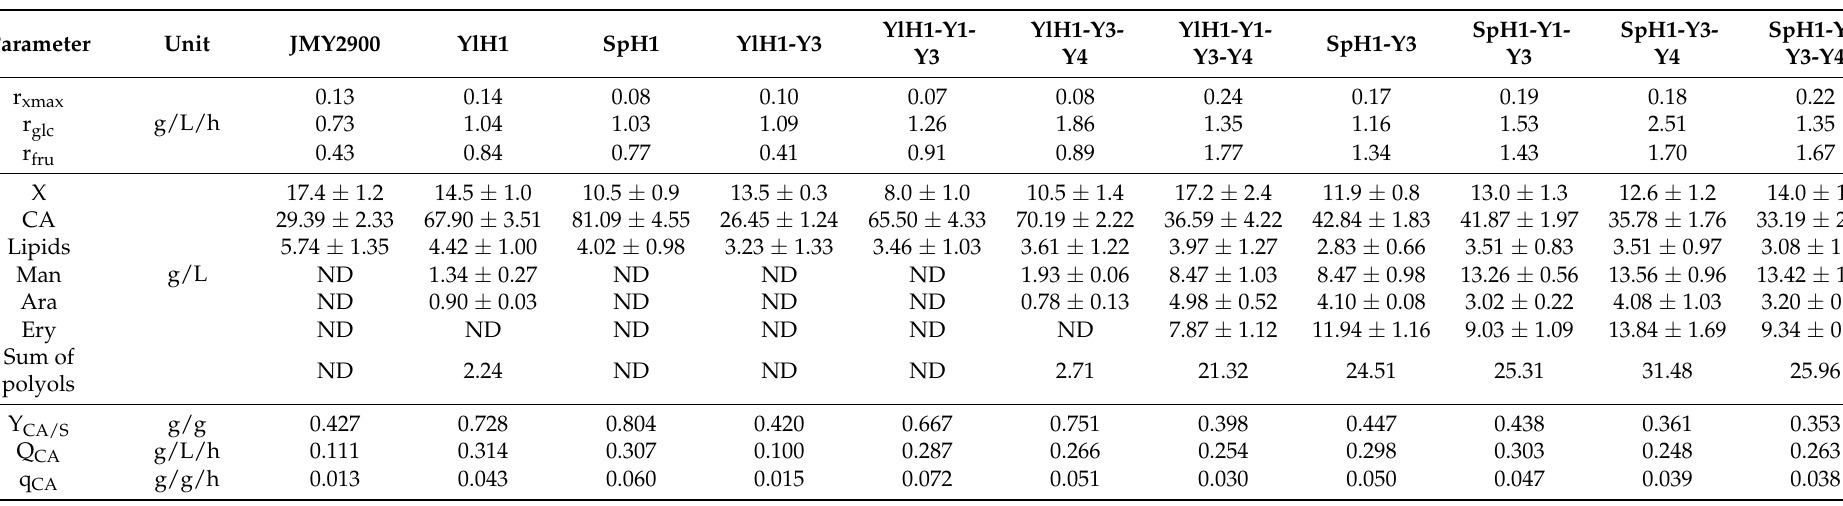
Table 1. Parameters of bioreactor cultures for citric acid production using Y. lipolytica transformants in defined medium with a mixture of glucose and fructose. The cultivations were carried out until complete depletion of the substrates or until 132 h (strains JMY2900, YlH1-Y3 and YlH1-Y3-Y4) and were performed in three biological